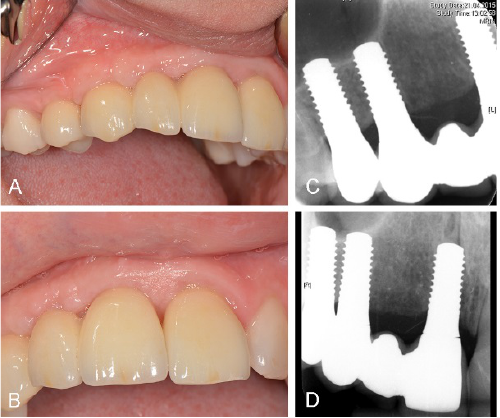
Figure 9. Clinical ( A , B ) and radiographic ( C , D ) investigation at 20 months after implant placement. FDP cemented on implants in region 11 and 13, single crown cemented on implant in region 14. Prosthetic reconstruction: Dr. Thomas